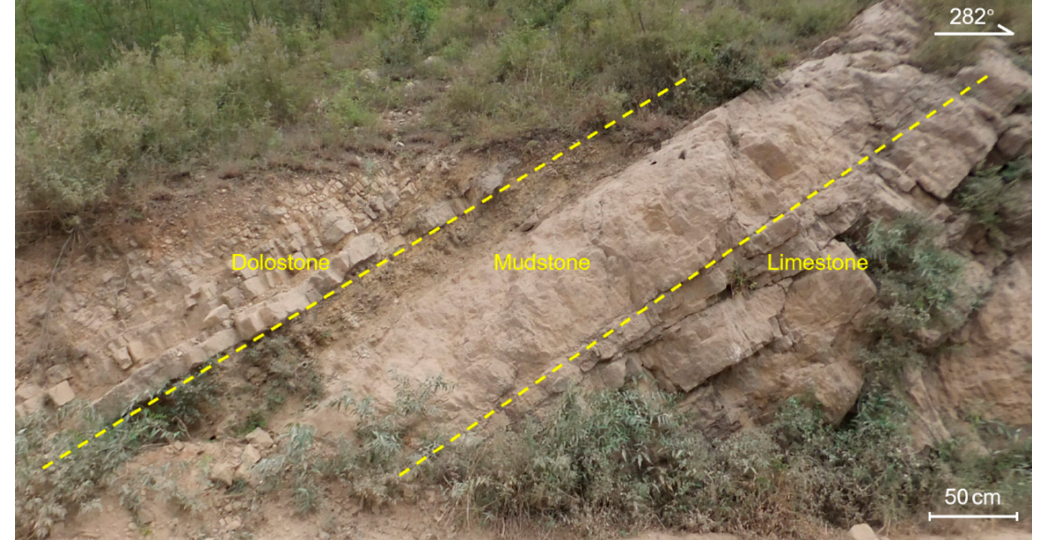
Figure 13. Tectonic fractures in different lithologies of carbonate rocks in the outcrops.